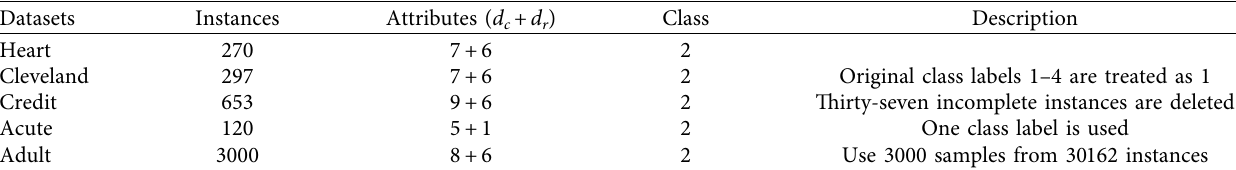
Table 3: Brief information of UCI mixed datasets.